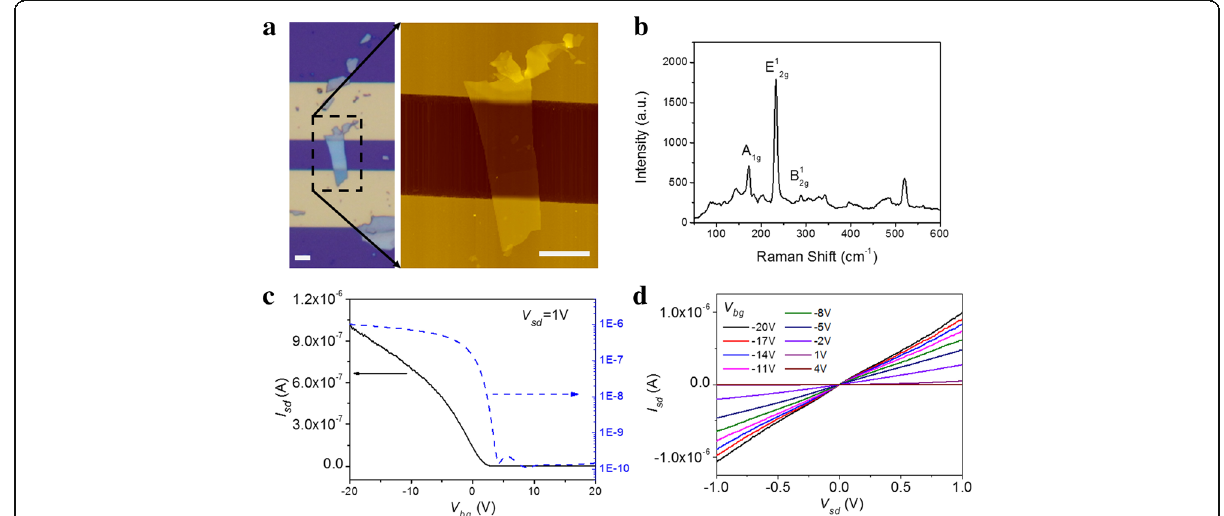
Fig. 1 a Optical image and AFM image of multi-layered MoTe 2 phototransistor. The scale bars are 5 μ m. b Raman spectrum of multi-layered MoTe 2 phototransistor with 514-nm laser excitation. c Transfer characteristics and d output characteristics of multi-layered MoTe 2